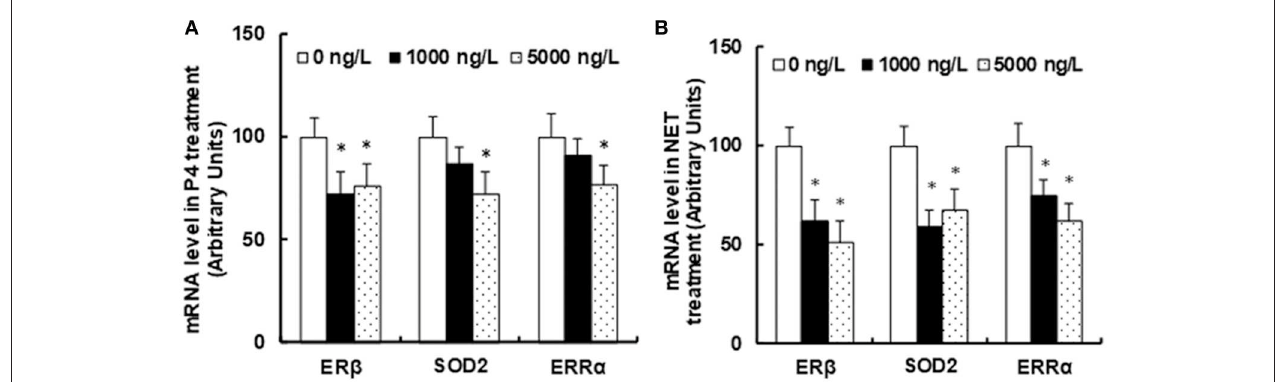
FIGURE 1 | Progestin exposure in water suppresses ER β expression and its target genes in the brains of zebrafish . Adult male zebrafish (10 months old) were exposed to 0, 500 or 1,000 ng/L of either endogenous (P4) or synthetic (NET) progestin in the water continuously for 1 month. The brains of zebrafish were isolated for the analysis of mRNA expression. (A) mRNA level in P4 treatment. (B) mRNA levels in NET treatment. n = 5, * P < 0.05, vs. 0 ng/L group. Results are expressed as mean ± SEM.